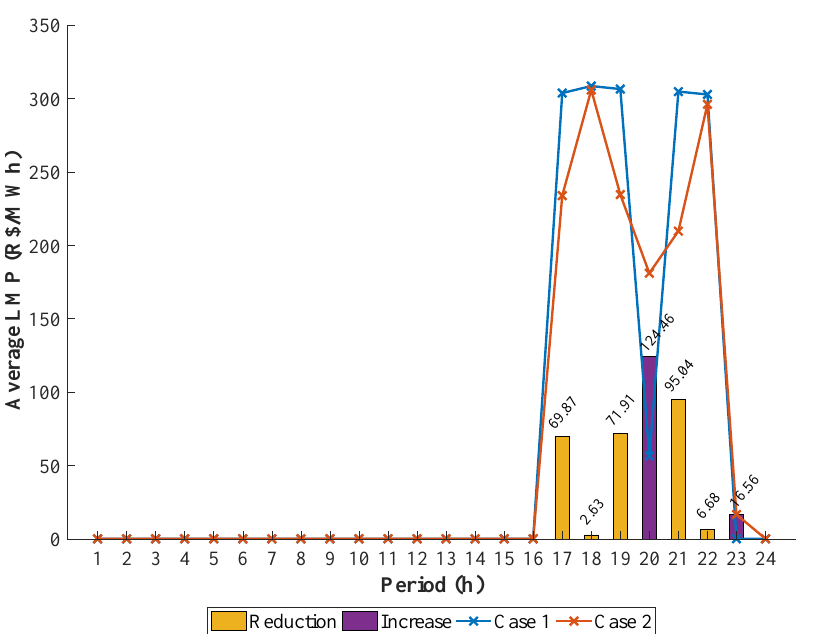
Figure 14. Average Locational Marginal Pricing (LMP) in Case 1 and Case 2. In the individual analysis of the LMP curves per bus, in Case 2, a negative value appears at 11:00 p.m. on bus 20, as shown in Figure 15. In this case, the energy previously dispatched from BESS makes TPP from bus 21 generates less energy power by TPP from bus 21, which is limited by its ramp rate constraint. To supply the demand at this time, an increase in the HPP from bus 23 was necessary, which caused the congestion of the transmission line 33 connecting buses 20 to 23 (Figure 16). The constraint at this time was significant making the cost paid for congestion and losses higher than the energy portion of the LMP.